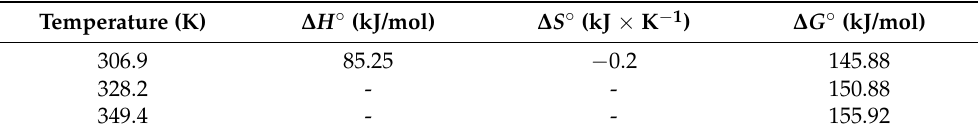
Table 8. Thermodynamic parameters of Cr (VI) adsorption on residual plantain pulp at pH = 2, C i = 200 mg/L and adsorbent dose = 0.5